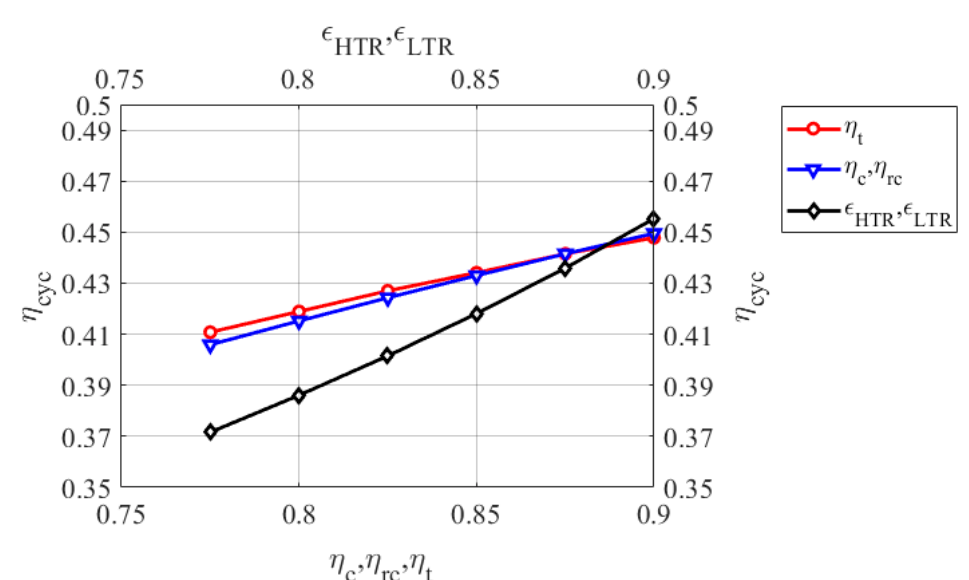
Figure 9. Effect of the compressor’s performance on the cycle’s efficiency.